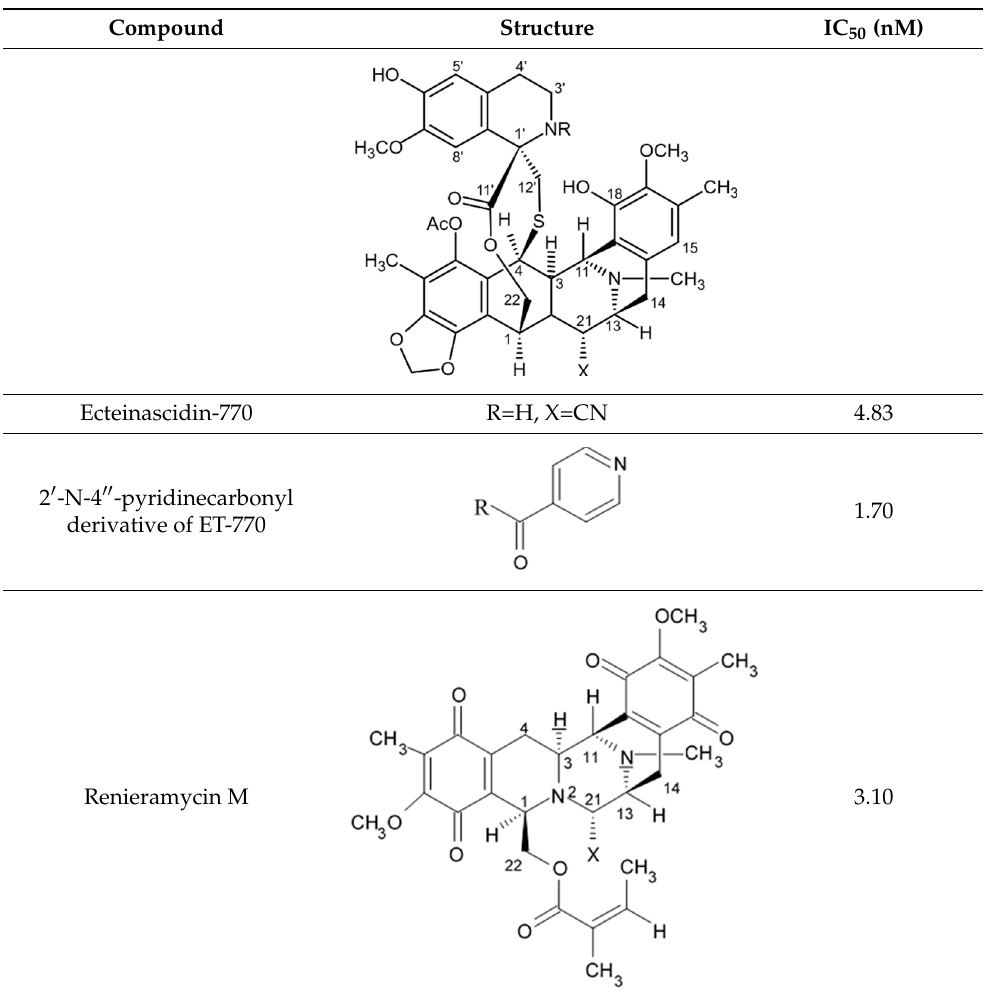
Table 5. Anti-glioblastoma activities of tetrahydroisoquinoline alkaloids against human glioblastoma cells U373MG [72].